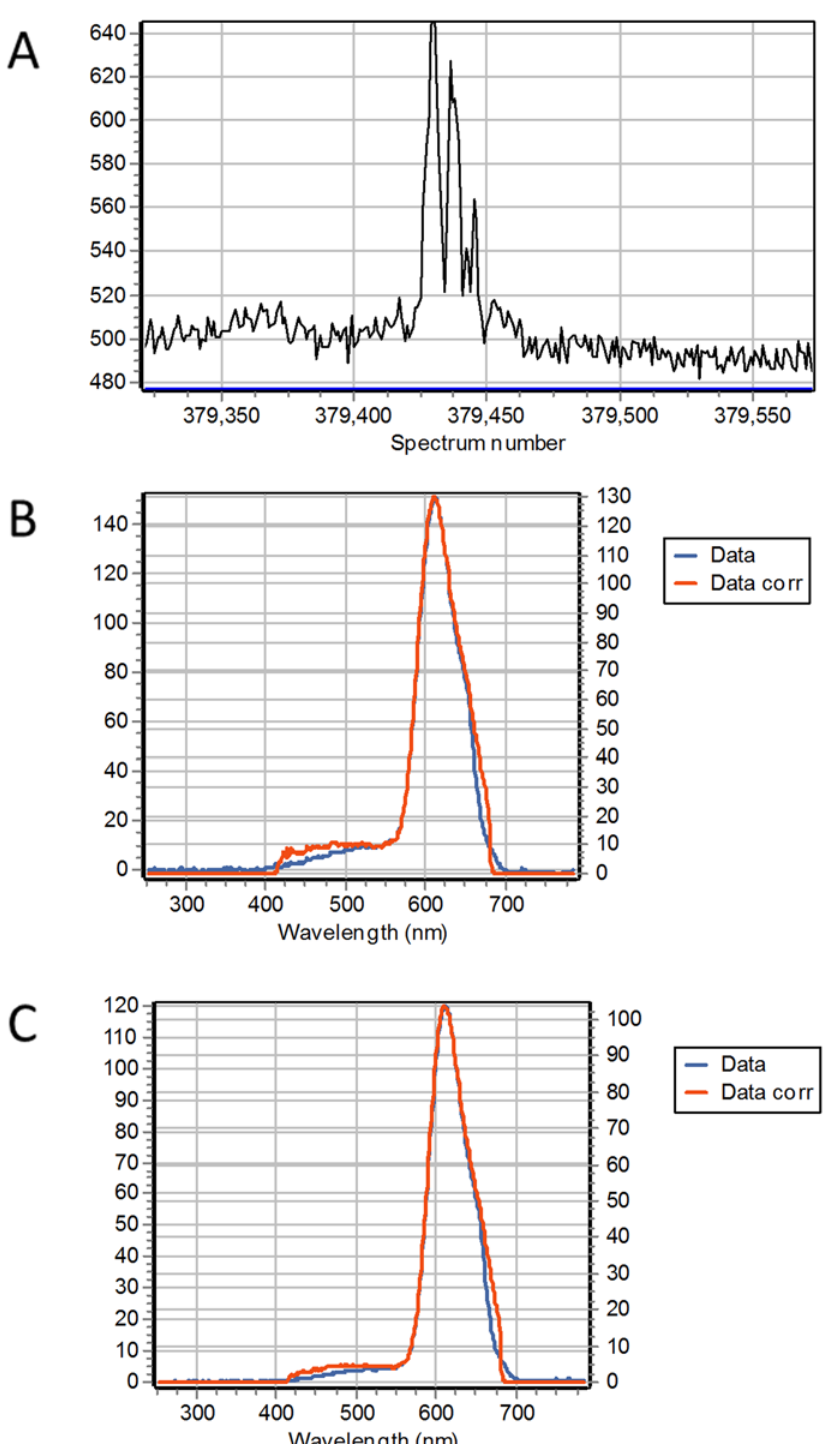
Fig 9. 1 nM AuNP suspension in the presence of 100nM mCherry. The excitation wavelength was 740 nm. In all graph the vertical axis is in intensity units from the Andor camera. (A) Intensity trace of a small region of the overall data collection. The intensity is obtained by the integrating the spectrum from 420nm to 680nm. A total of 500,000 spectra were collected every 200 microseconds. Occasional burst are observed along the intensity trace above the average spectral intensity due to mCherry in solution. (B) The